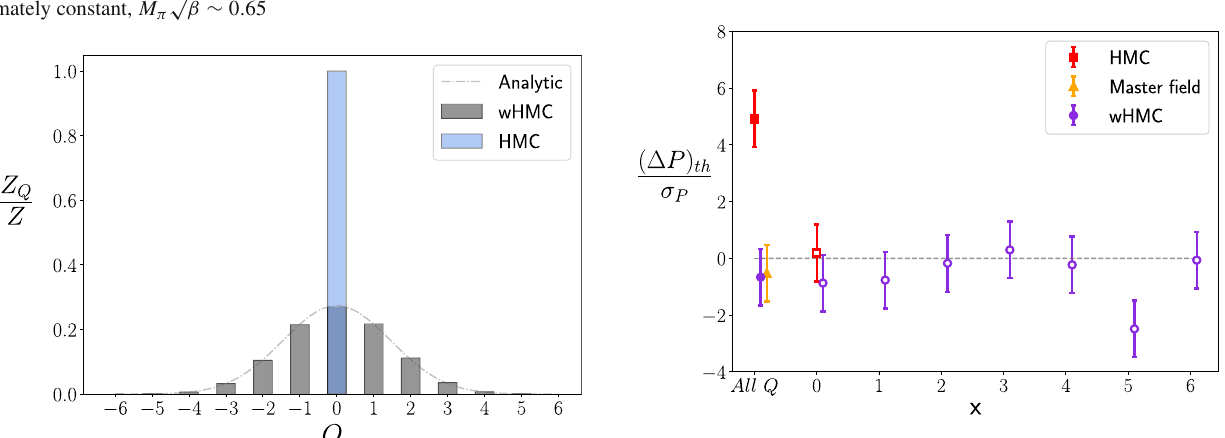
Fig. 13 ((cid:12) P ) th ≡ P x − P th x normalized with the standard deviation σ for x = All Q (full symbols) or at fixed topology x = | Q | (open symbols), at β = 11 . 25 for wHMC, HMC and master field, compared to the analytical result (dashed